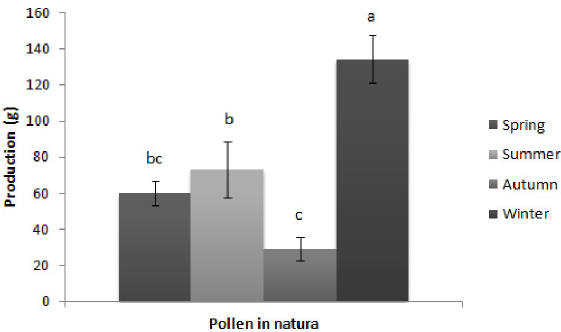
Figure 1 - Bee pollen in natura production averages, collected in different seasons by Apis mellifera